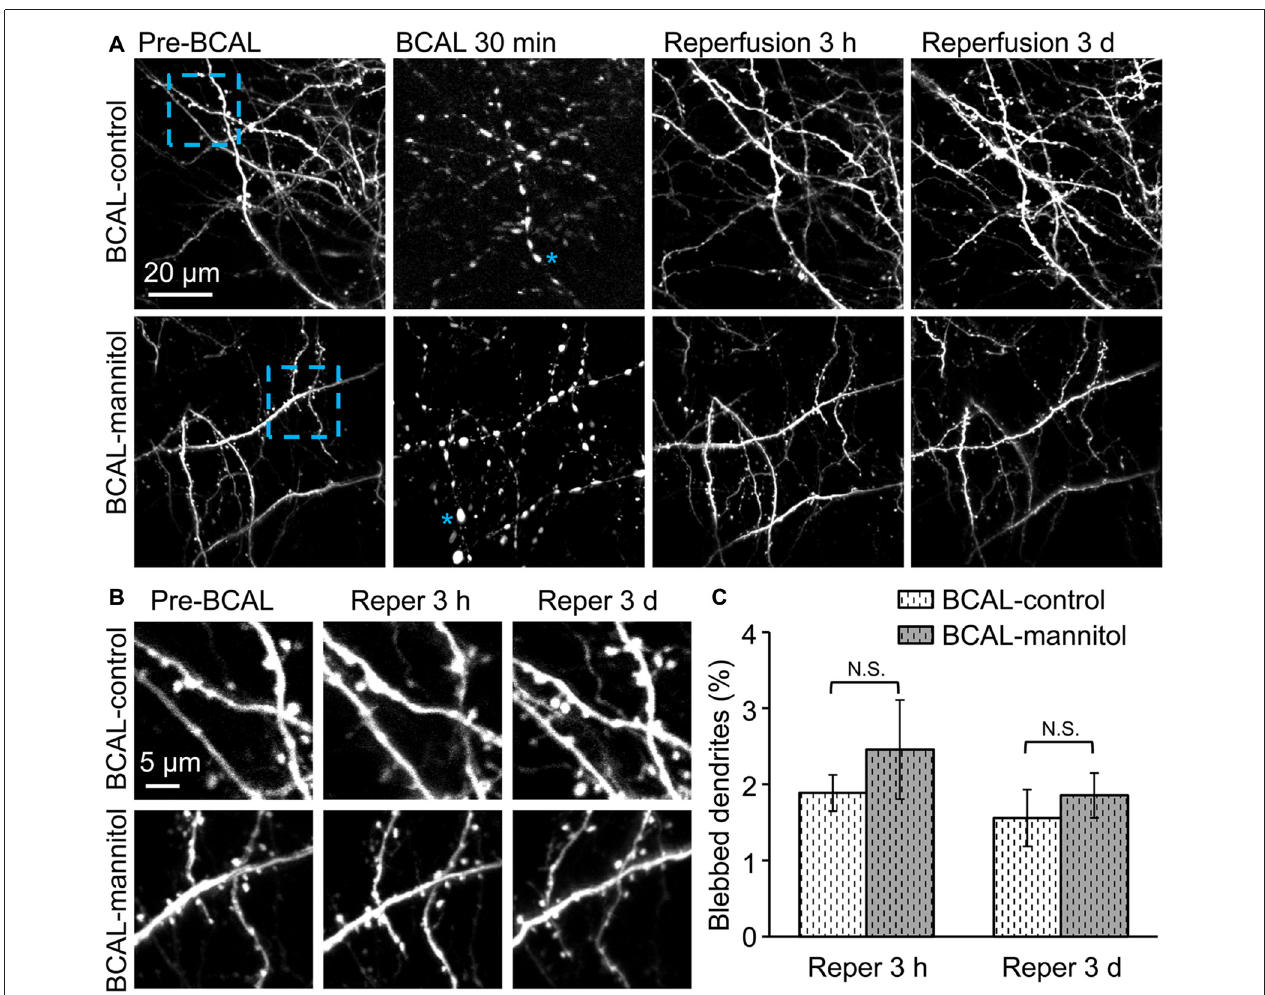
FIGURE 4 | Mannitol did not affect the reversible recovery of the dendritic structure following global cerebral ischemia/reperfusion. (A) Morphological changes in dendritic structures before ischemia, 30 min after ischemia, 3 h and 3 days after reperfusion. Note that most of the blebbed dendrites recovered at 3 h after reperfusion. Asterisk ( ∗ ) indicates blebbed dendrite. (B) Magnified view of the blue-boxed region in (A) showing dendritic structures before ischemia, at 3 h and 3 days after reperfusion. Note that mannitol-induced extravasation did not affect the reversible recovery of the dendritic structures. (C) Quantification of the percentage of blebbed dendrites in ischemic animals treated with mannitol or saline at 3 h and 3 days after reperfusion ( n = 6 mice, each group). Note that there is no significant difference in dendritic beading in mannitol-injected mice and saline-injected mice. N.S., p >